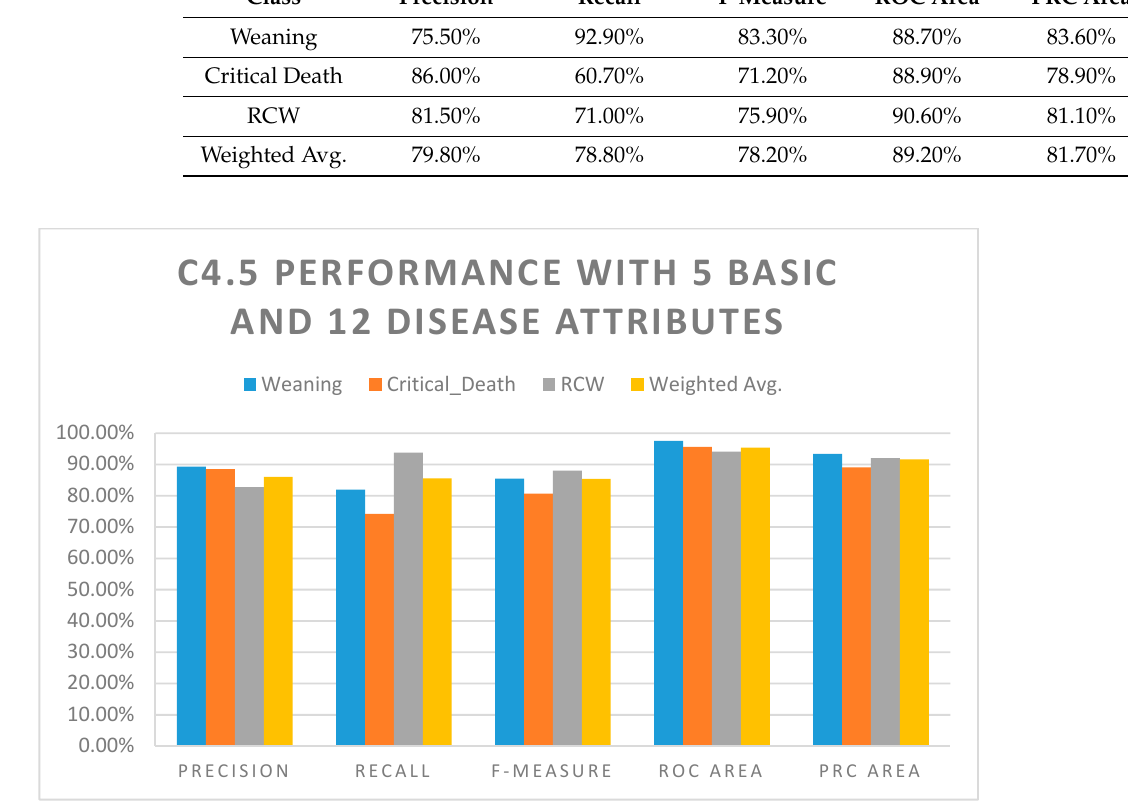
Figure 2. C4.5 algorithm performance for Model II with 5 basic and 12 disease attributes.